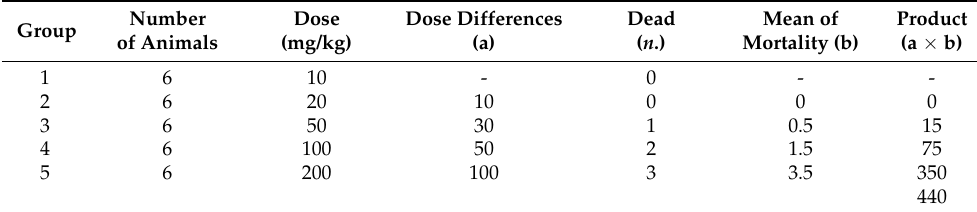
Table 3. LD 50 determination according to the Karbar method.